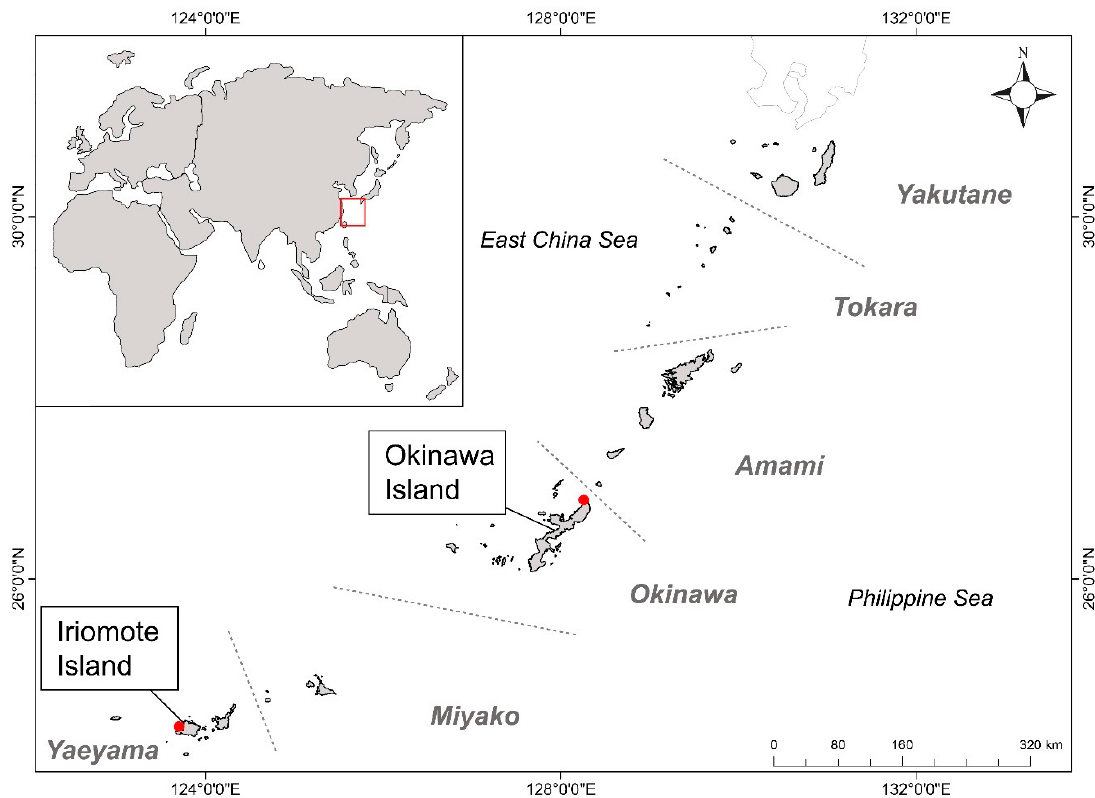
Figure 1. Map of the Ryukyus Islands (RYS), with the six island group divisions (grey dotted lines) and the two dive locations where Hadaka nudidomus gen. nov. et sp. nov. specimens were found (red dots) at Iriomote (NSMT-Co 1681, holotype) and Okinawa (NSMT-Co 1682, paratype) Islands.